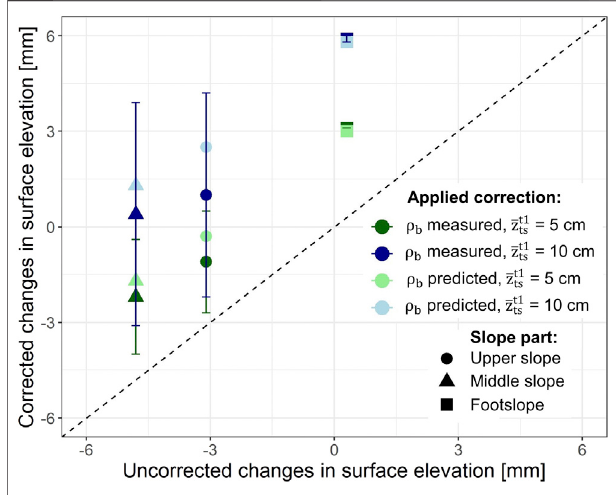
FIGURE 6 | Uncorrected vs. corrected soil elevation changes [mm] between May 14 and May 16 in the upper slope, middle slope, footslope. The soil height elevation changes were corrected for consolidation by the measured fi nal bulk density ρ b assuming a thickness of the tilled soil, (cid:2) z t 1 ts , of 5 and 10 cm and corrected for consolidation by the predicted fi nal bulk density ρ b assuming a thickness of the tilled soil, (cid:2) z t 1 ts , of 5 and 10 cm.